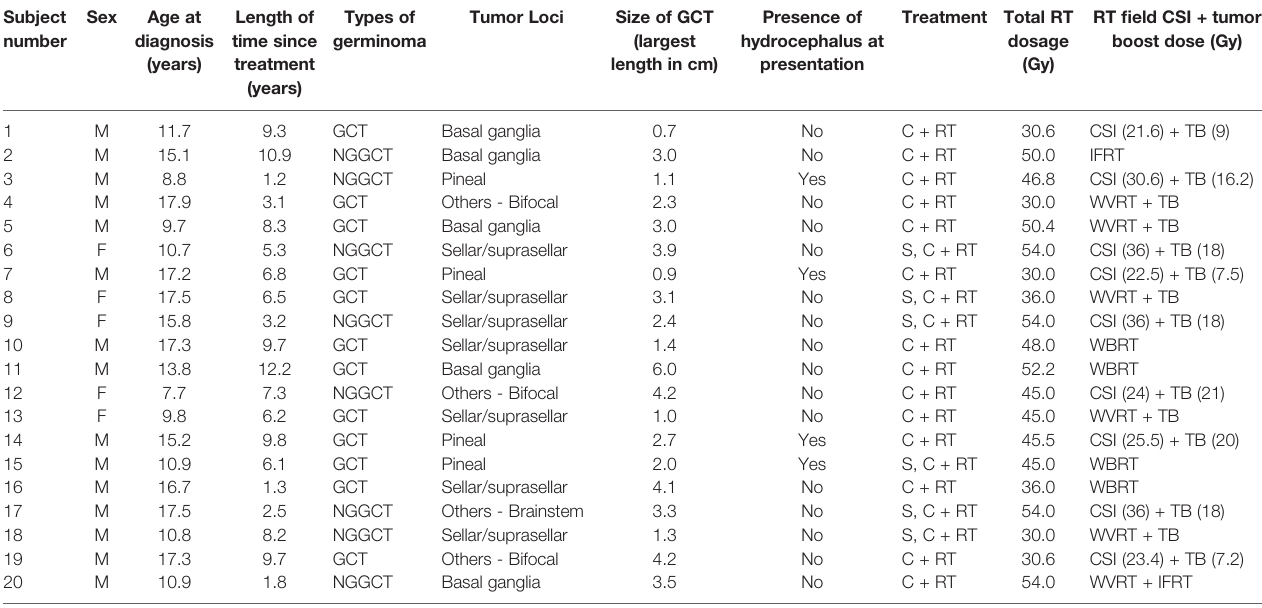
TABLE 1 | Clinical Characteristics of GCT